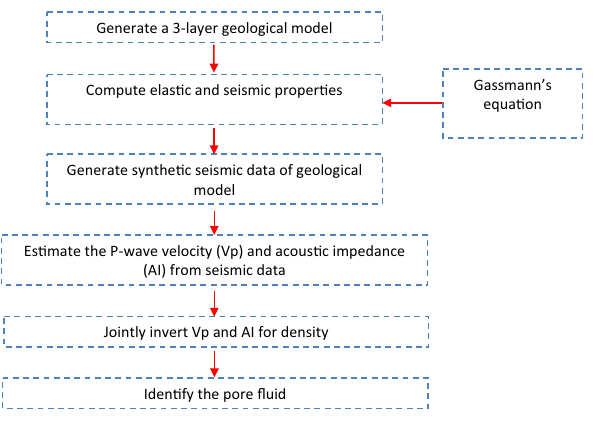
Fig. 1 Flowchart of the proposed inversion